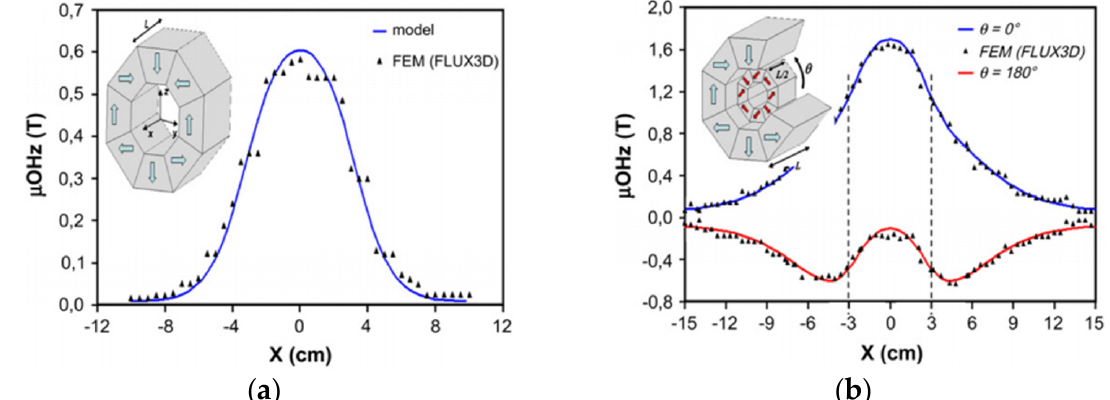
Figure 5. Magnetic flux density distribution versus the position. Analytical calculation results with the 3-D FEM for a: ( a ) simple Halbach cylinder; ( b ) double Halbach cylinder [39].